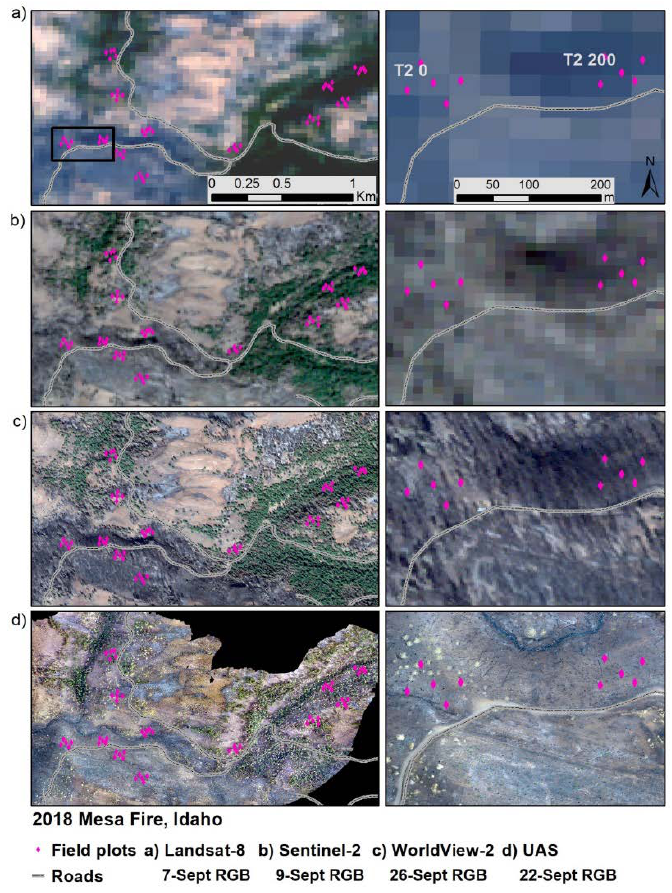
Figure 11. Spatial comparison of ( a ) Landsat-8 (30 m pixel; day 43), ( b ) Sentinel-2 (10 m pixel; day 45), ( c ) WorldView-2 (2 m pixel; day 62), and ( d ) a UAS image (0.6 m pixel; day 58) at the field sites. The right column is a zoom-in on Transect 2 at the Mesa Fire, which is a high severity transect that had an average ash cover of 85% on 8 September (day 44) and 80% on 22 September (day 58).